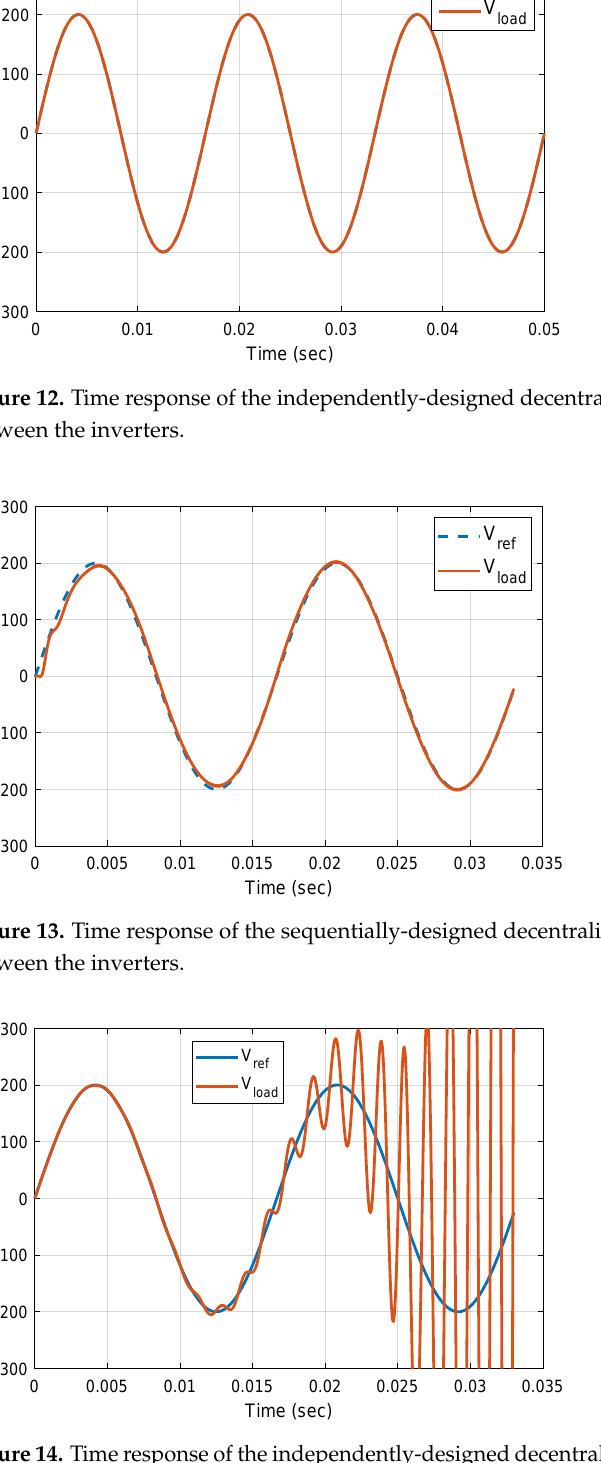
Figure 14. Time response of the independently-designed decentralized controllers for 200 (m) distance between the